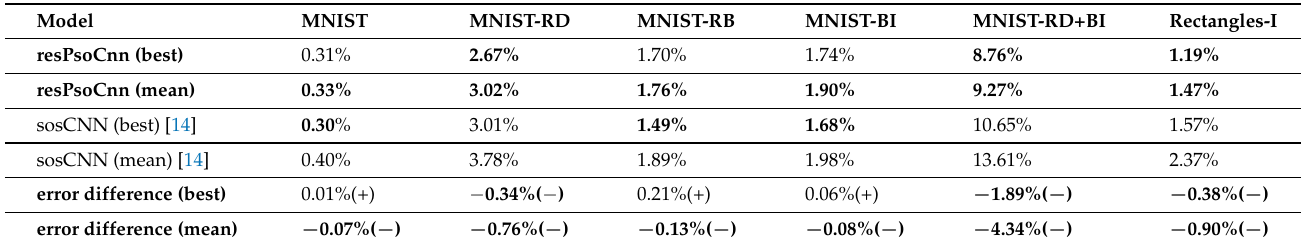
Table 6. The best and mean error rates over 10 runs for the proposed method, resPsoCnn and the best baseline method, sosCNN [14], where a ( − )/(+) symbol indicates that resPsoCnn performed better/worse than